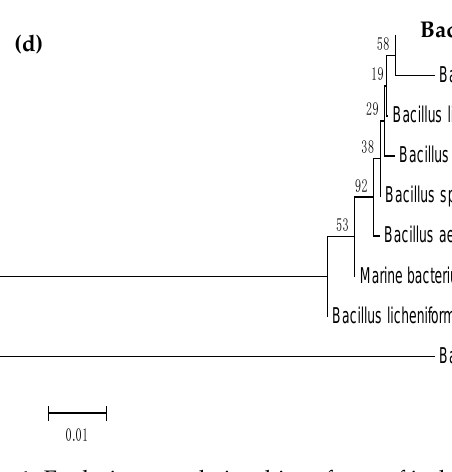
Figure 1. Evolutionary relationships of taxa of isolate ( a ) HIP1, ( b ) HIP2, ( c ) HIP3, and ( d ) HIO1. The evolutionary history was inferred using the neighbor-joining method. The percentage of replicate trees in which the associated taxa clustered together in the bootstrap test (100 replicates) is shown next to the branches. The tree is drawn to scale, with branch lengths in the same units as those of the evolutionary distances used to infer the phylogenetic tree. The evolutionary distances were computed using the Maximum Composite Likelihood method and are in the units of the number of base substitutions per site. The analysis involved 37 nucleotide sequences. All positions containing gaps and missing data were eliminated. Evolutionary analyses were conducted in MEGA5.